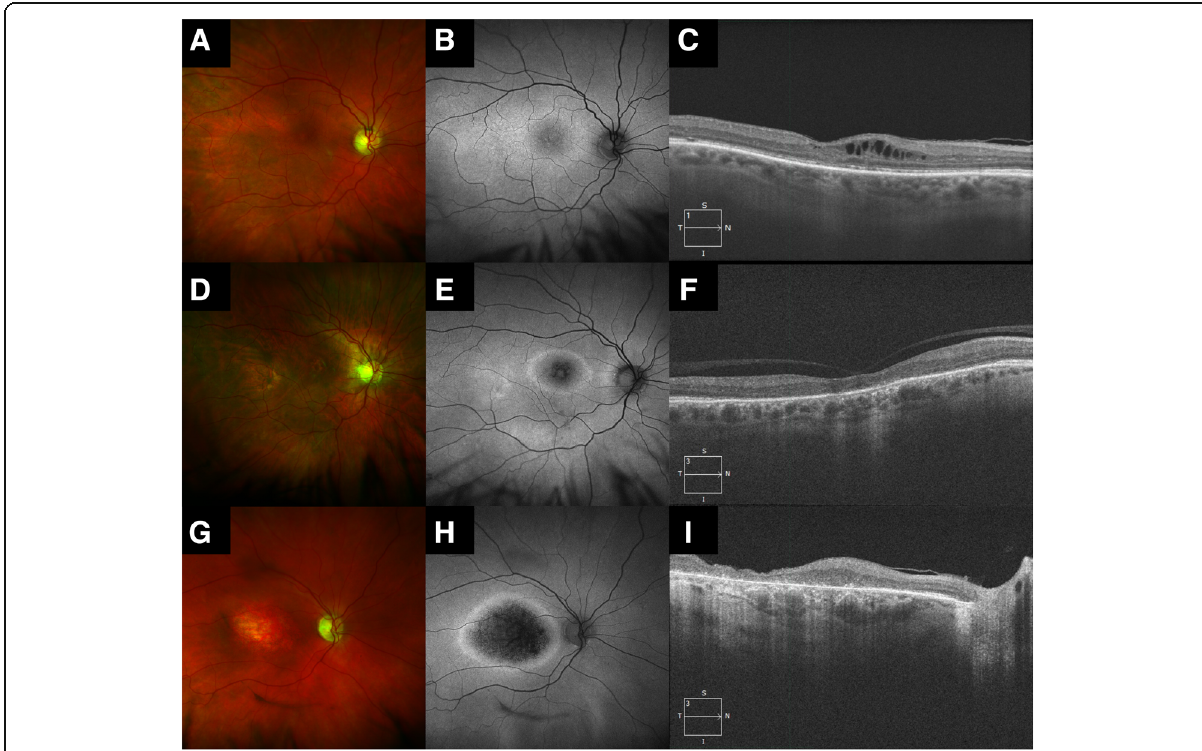
Fig. 2 Phenotypic features of selected cases from this XLRS1 pedigree. Colour photographs (left column), autofluorescence (middle column), and SD-OCT (right column) of the right eyes of 3 patients in Stage 1 (top row), Stage 2 (middle row) and Stage 3 (bottom row). Further description